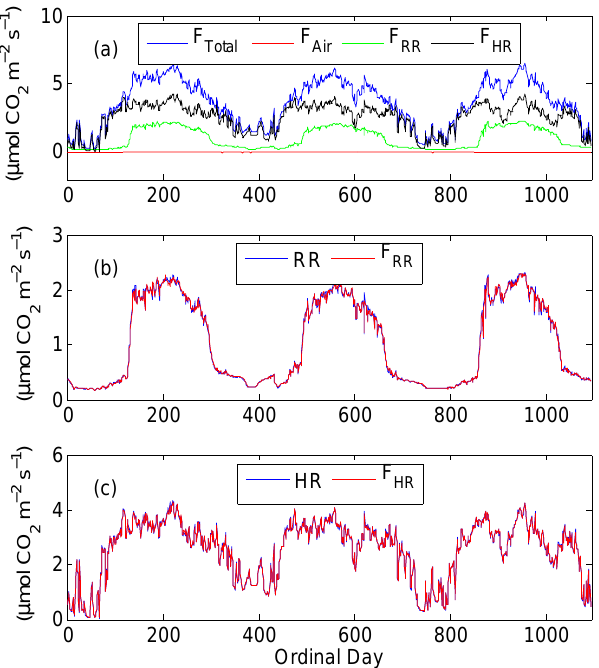
Fig. 7. A comparison of the simulated component-wise soil surface CO 2 effluxes and their belowground production rates. F Air , F RR , and F HR are, respectively, the surface CO 2 effluxes corresponding to atmospheric CO 2 (Air), production from autotrophic root respi- ration (RR), and soil heterotrophic respiration (SR). F Total is the sum of F Air , F RR , and F HR .